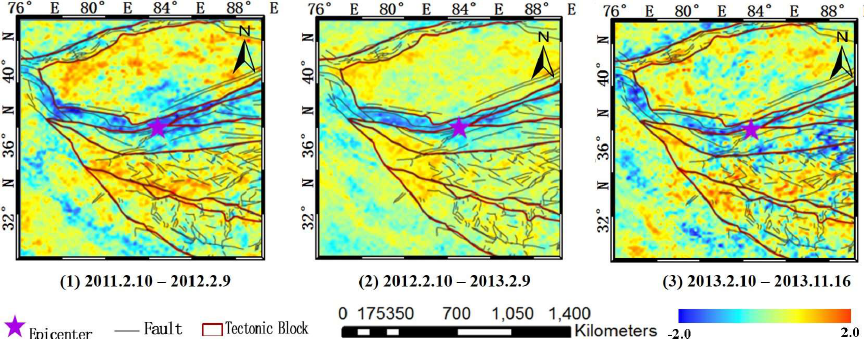
Figure 11. TIR anomalies prior to the Yutian earthquake event in different periods.